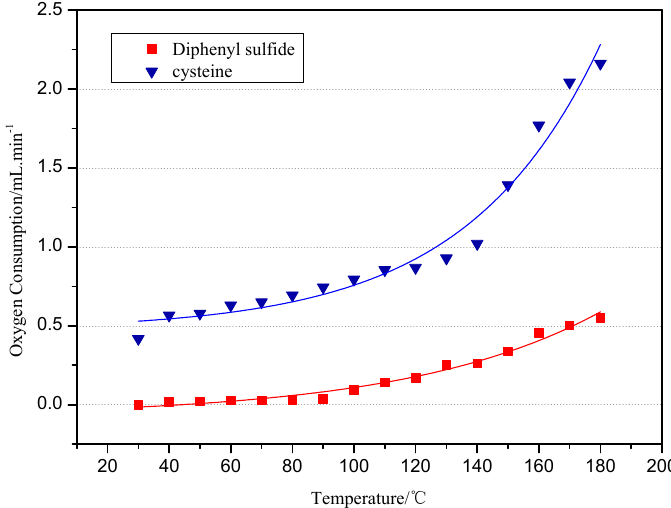
Figure 1. The relationship between the O 2 consumption and oxidation temperature.